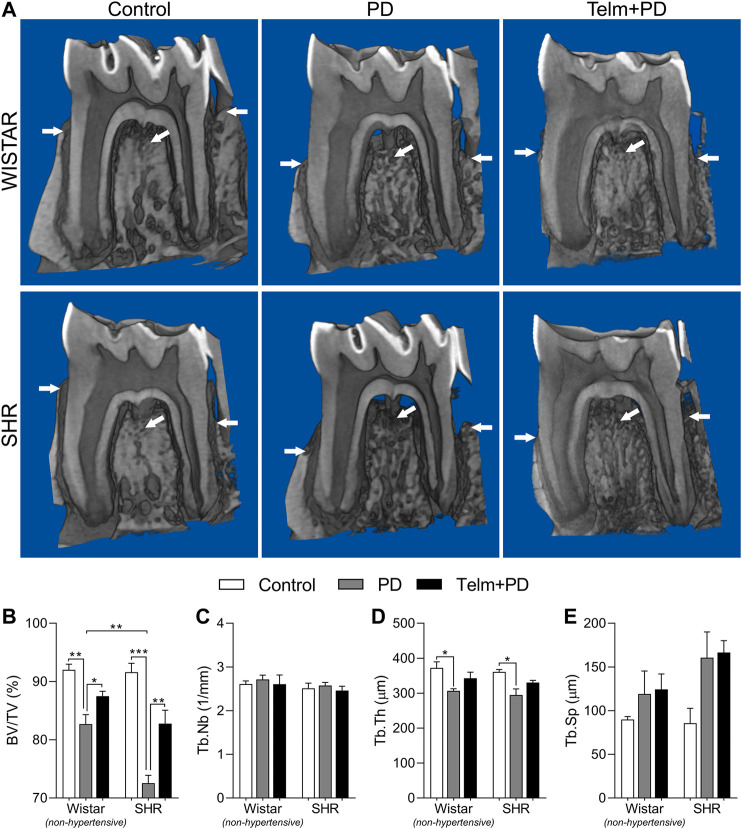
Microtomography analysis of mandible of Wistar (non-hypertensive) and SHR with PD 15 days, treated with telmisartan. Mandible three-dimensional reconstruction in lingual view with cut in the furcation region (white arrow indicate sites of significant bone resorption) (A), and graphs showing %BV/TV (B), Tb.Nb (C), Tb.Th (D), and Tb.Sp (E) as mean ± SEM (n = 5). Statistical difference are represented by brackets labeled by *p < 0.05, **p < 0.01, ***p < 0.001, and ****p < 0.0001, comparing Control vs. PD, PD vs. Telm + PD, and Wistar vs. SHR in the same experimental condition.